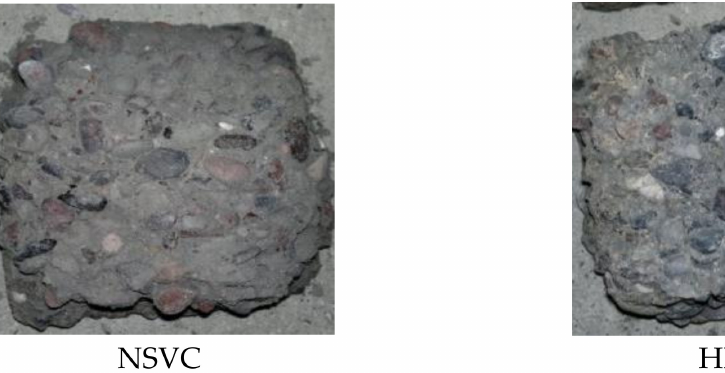
Figure 6. The cleaned core of broken cubes heated to 700 ◦